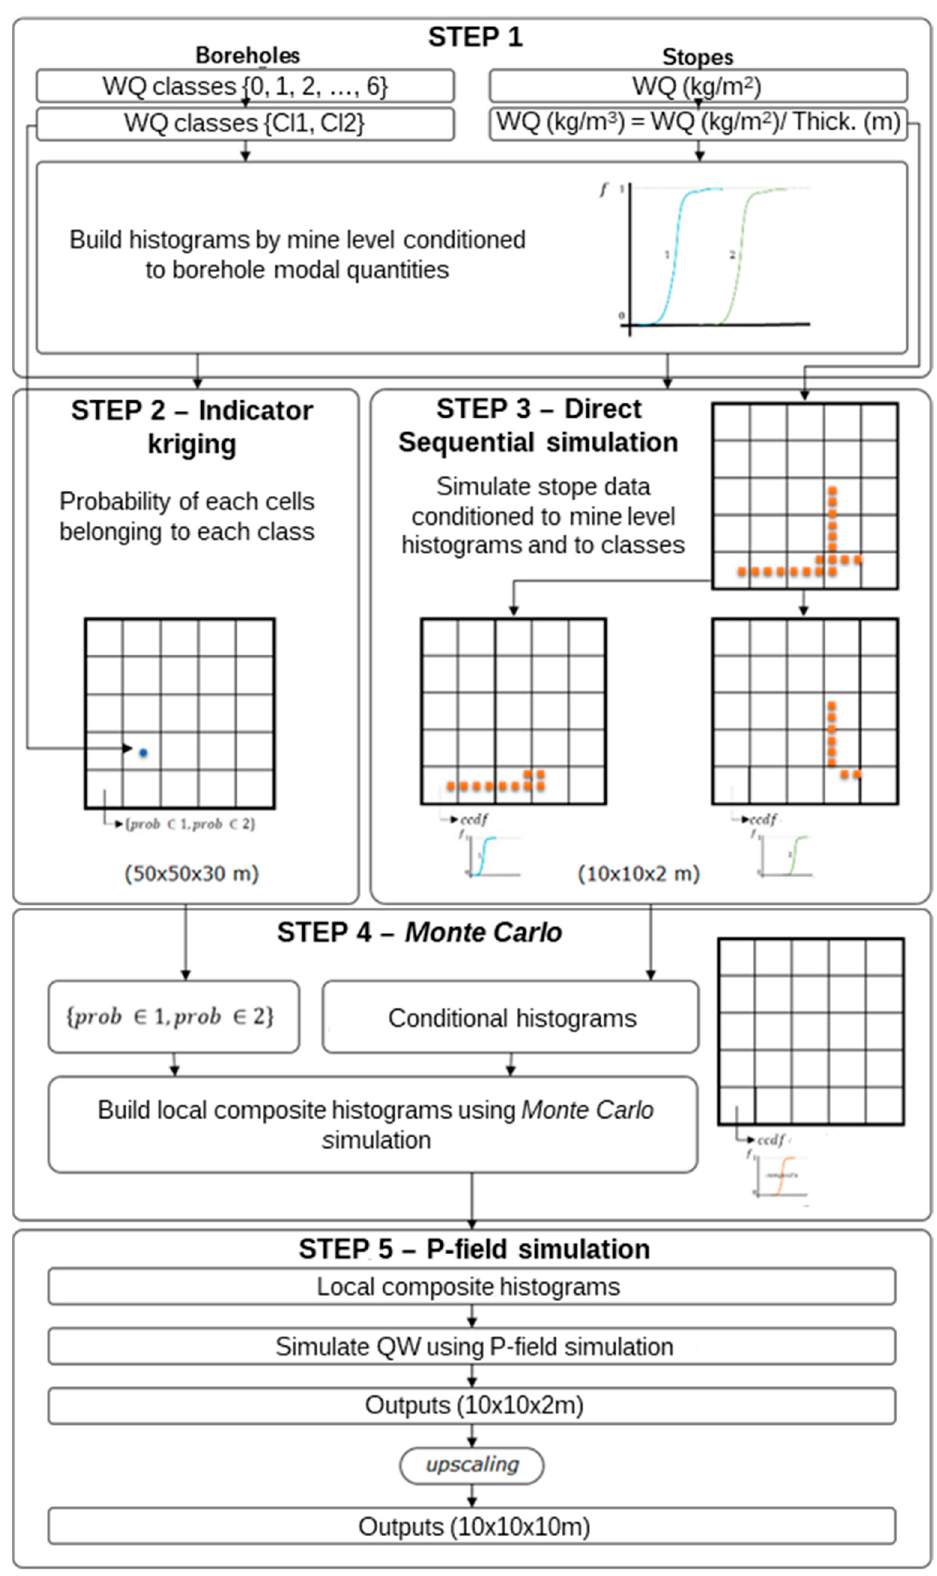
Figure A2. Wolframite content methodology flowchart.